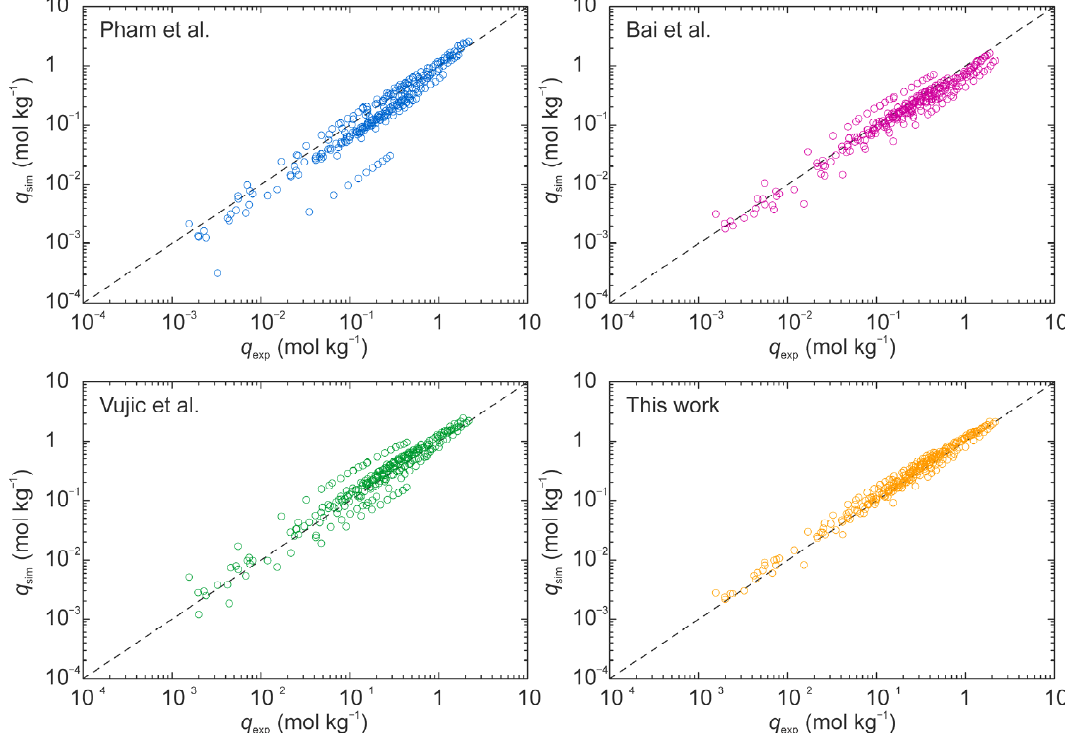
Figure 7. Comparison of simulated amount of adsorbed CO 2 and CH 4, using several parameters of the experimental data.